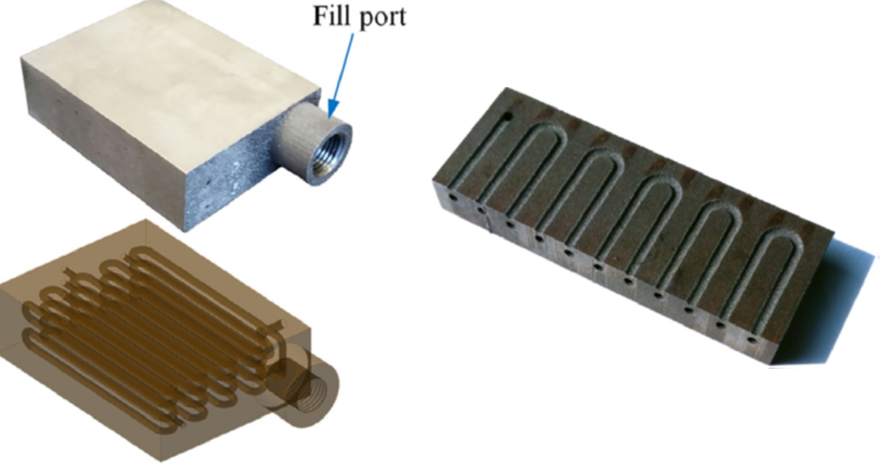
Figure 19. Photo of Ti–6Al–4V oscillating HP ( top left ), the transparent view of the oscillating HP ( bottom left ), photo of the sectioned prototype ( top right ) [44,45].